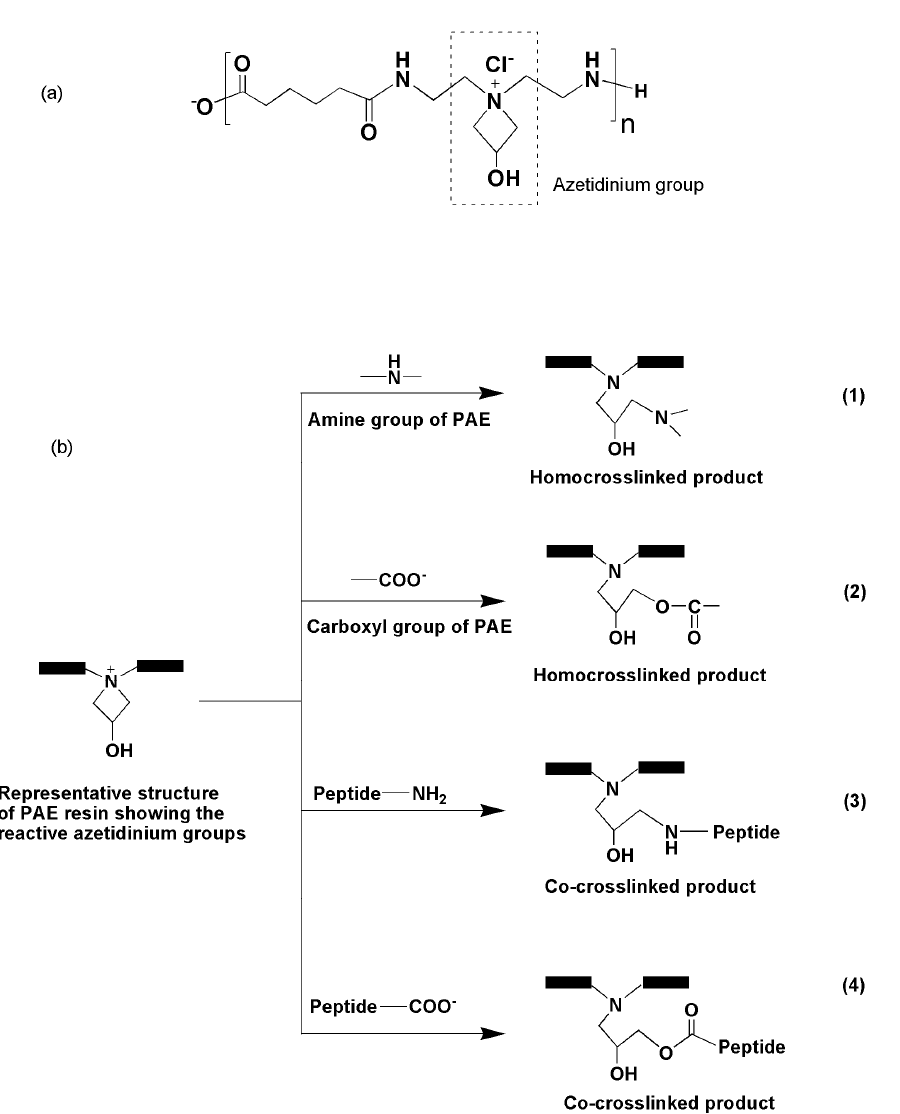
Figure 1. Chemical structure of PAE resin ( a ); and plausible chemical reactions occurring during chemical crosslinking of PAE resin with peptides ( b ). Reactions (1) and (2) represent self-crosslinking reactions of PAE molecules, which occur due to the reactions of the azetidinium groups with secondary amines (Reaction (1)) as well as terminal carboxylate groups (Reaction (2)) of PAE producing a homocrosslinked polymer [12,20–23]. Co-crosslinking of PAE resin and peptides occurs due to the reactions of azetidinium groups of the resin with amine (Reaction (3)) and carboxylate (Reaction (4)) groups of the peptides [12,20].